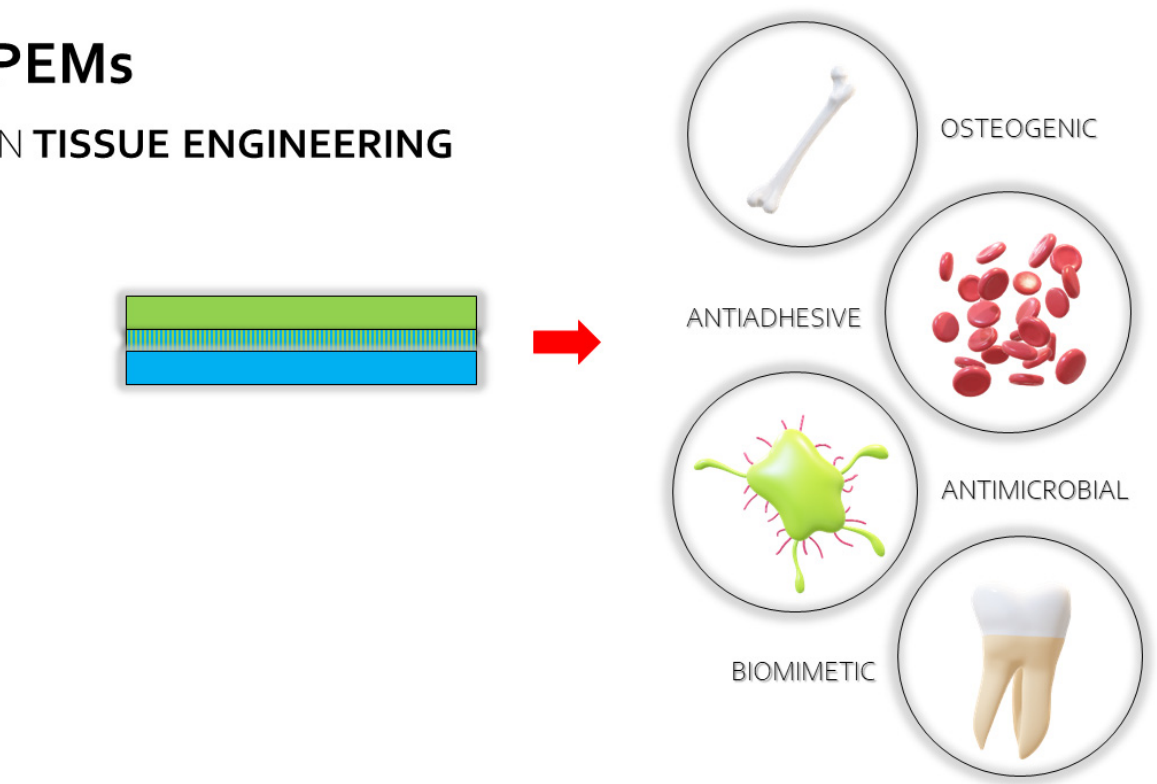
Figure 5. The possible utilization of PEMs in tissue